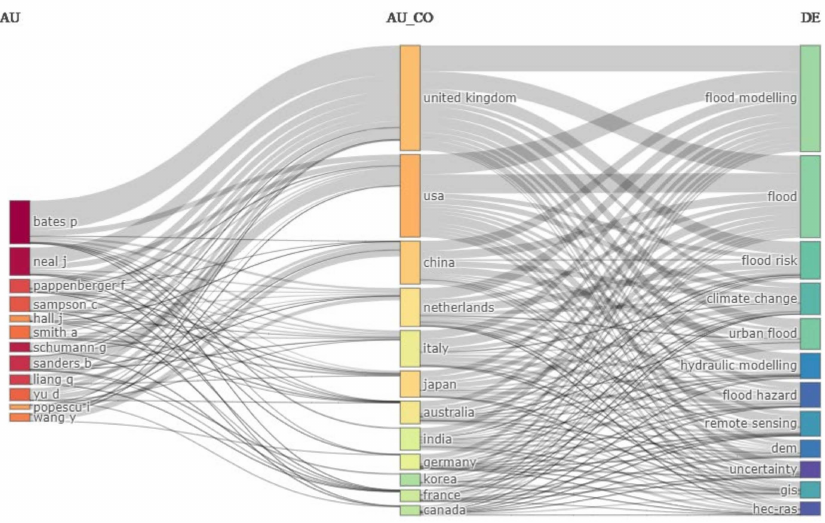
Figure 10. Analysis of the Sankey diagram. Author–country–keyword